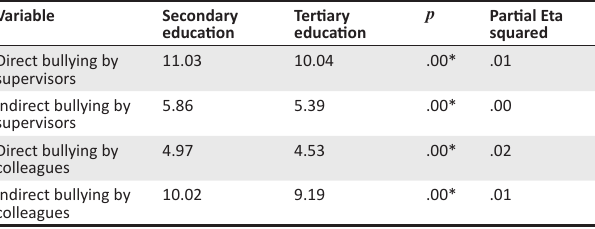
TABLE 8: Analysis of variance – differences in workplace bullying based on